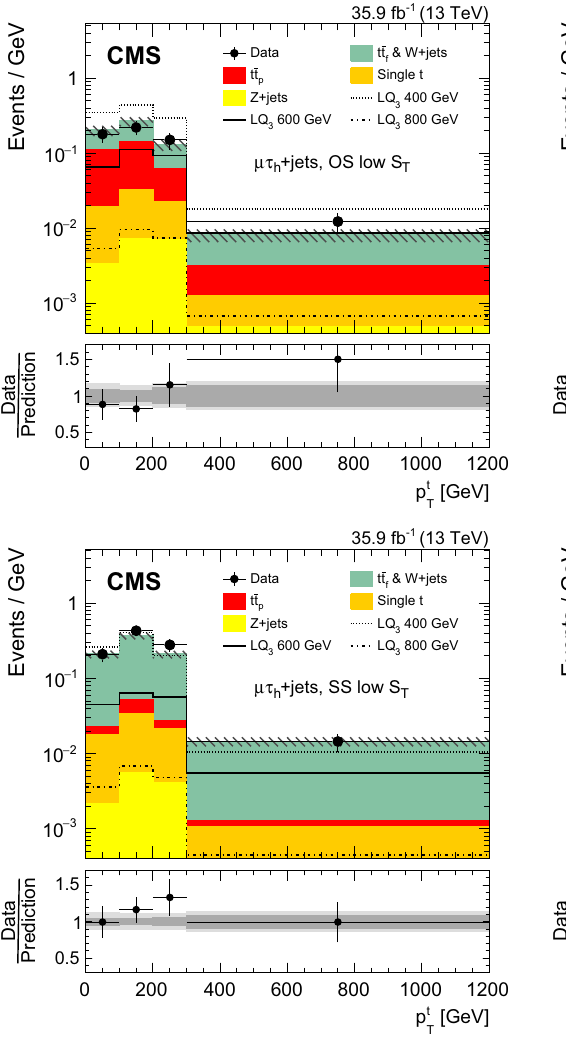
tom panel, the ratio of data to SM background is shown together with statistical (dark gray) and total (light gray) uncertainties of the total SM